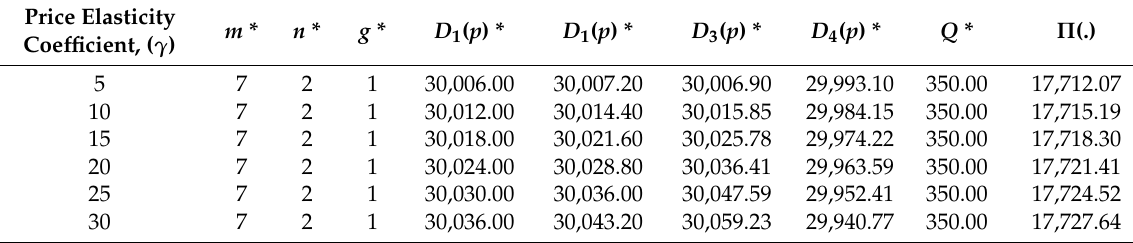
Figure 2. The Effect of Changes in the Price Elasticity Coefficient on Profitand Demand. Table 6. Effect of Changes in the Price Elasticity Coefficient